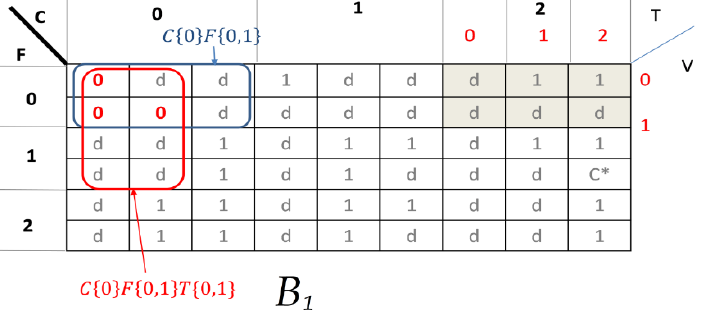
{ } of 𝑩 , assuming 𝒍 C* =